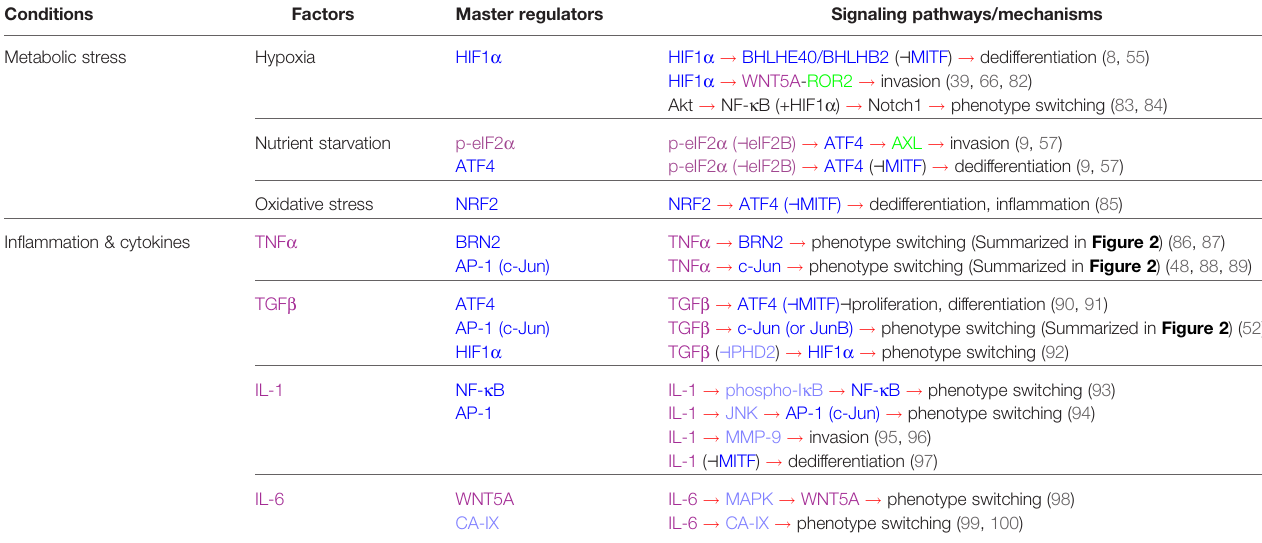
TABLE 2 | Stress-speci fi c pathways driving melanoma phenotype switching. Conditions